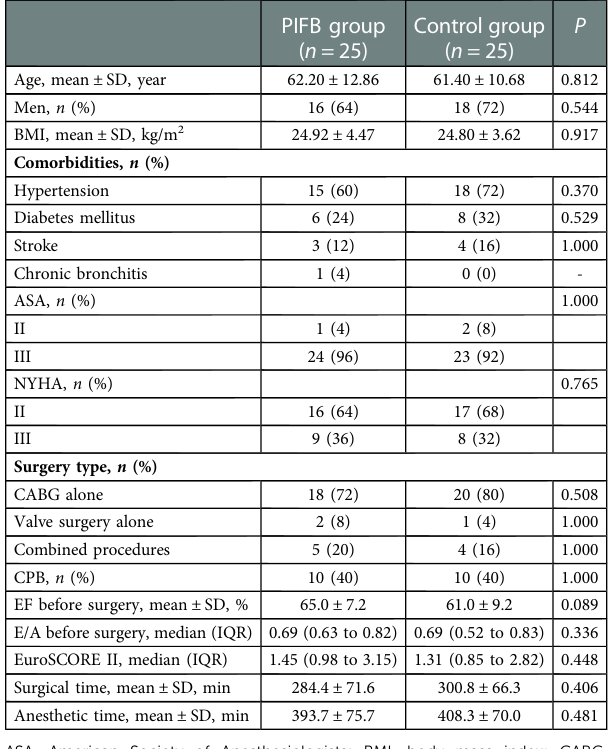
TABLE 1 Demographic and baseline characteristics. TABLE 2 Primary and secondary